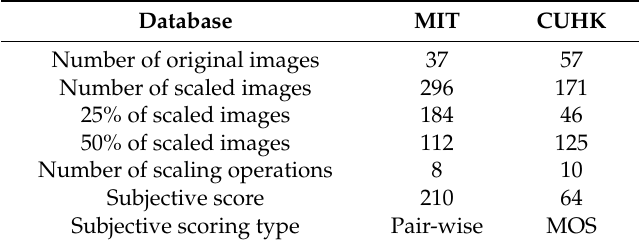
Table 1. Image retargeting quality assessment (IRQA) benchmark database information comparison